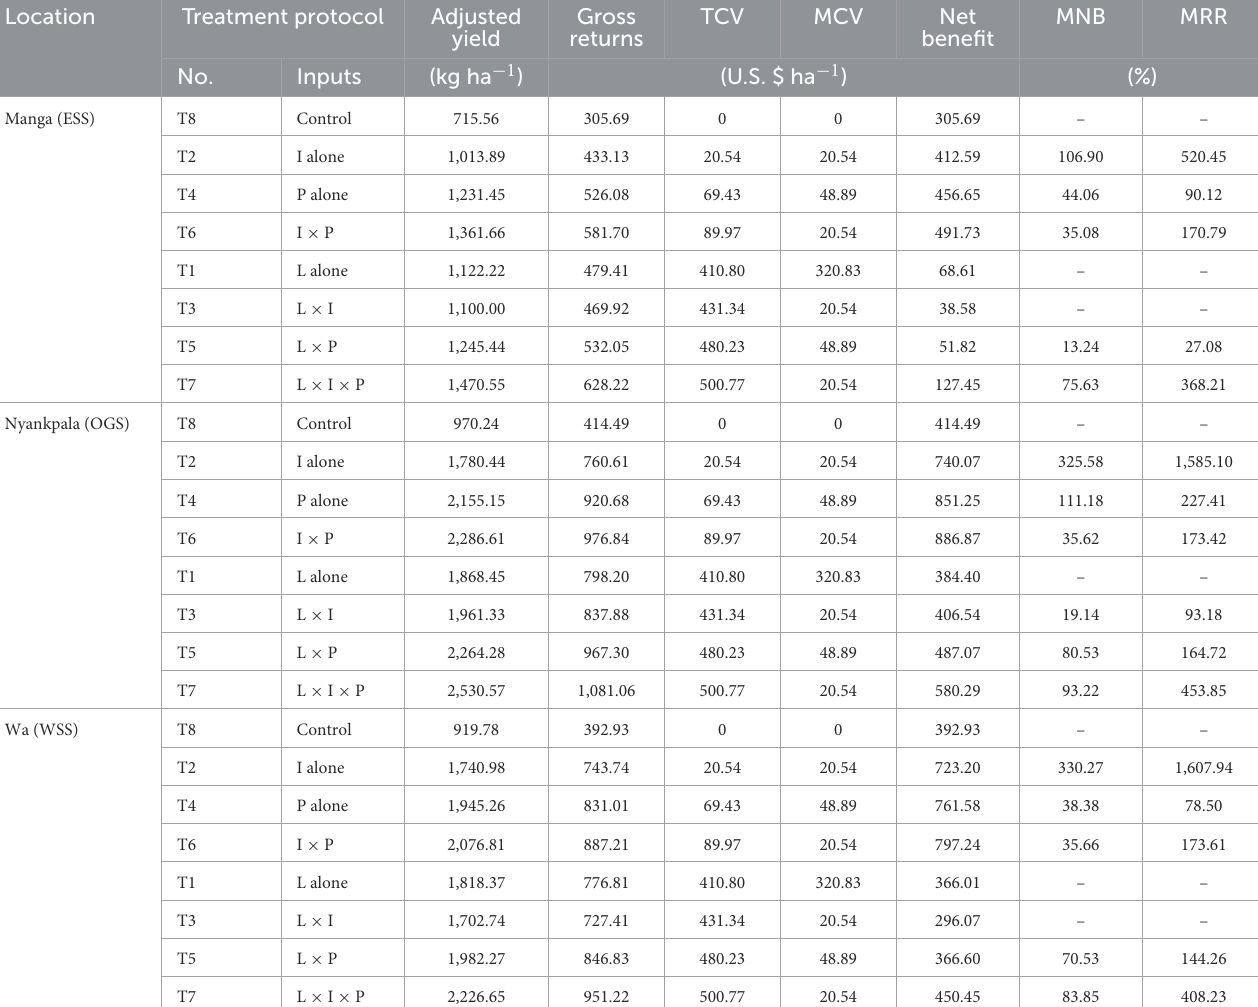
TABLE 7 A 3-yr (2017 to 2019) partial budget analysis of lime, Bradyrhizobium inoculum, and phosphorus effects on soybean at Manga, Nyankpala, and Wa locations.